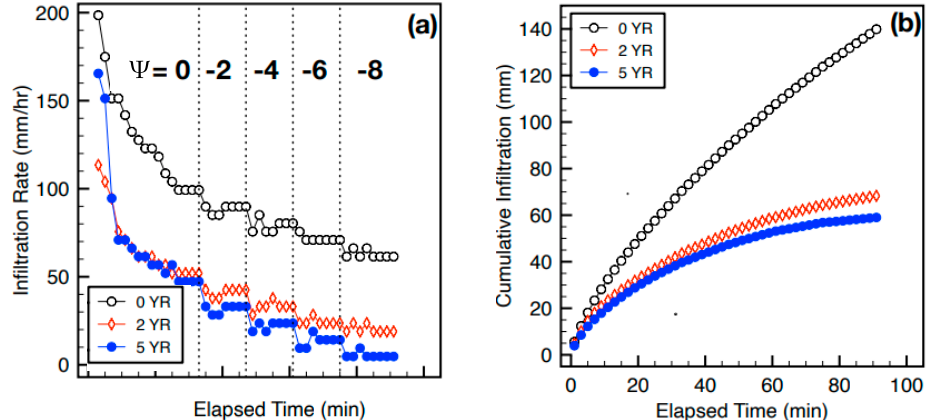
Figure 1. ( a ) Instantaneous infiltration rates associated with the first replicate; ( b ) mean cumulative infiltration curves obtained on the three plots with different earlier irrigation treatments (0YR, 2YR, and 5YR) [9]. Table 2. Saturated hydraulic conductivity, K s , and sorptive number, α , estimated through the procedure described in Section 2.2 and averaged on five replicates of the infiltration tests performed on each plot [9].